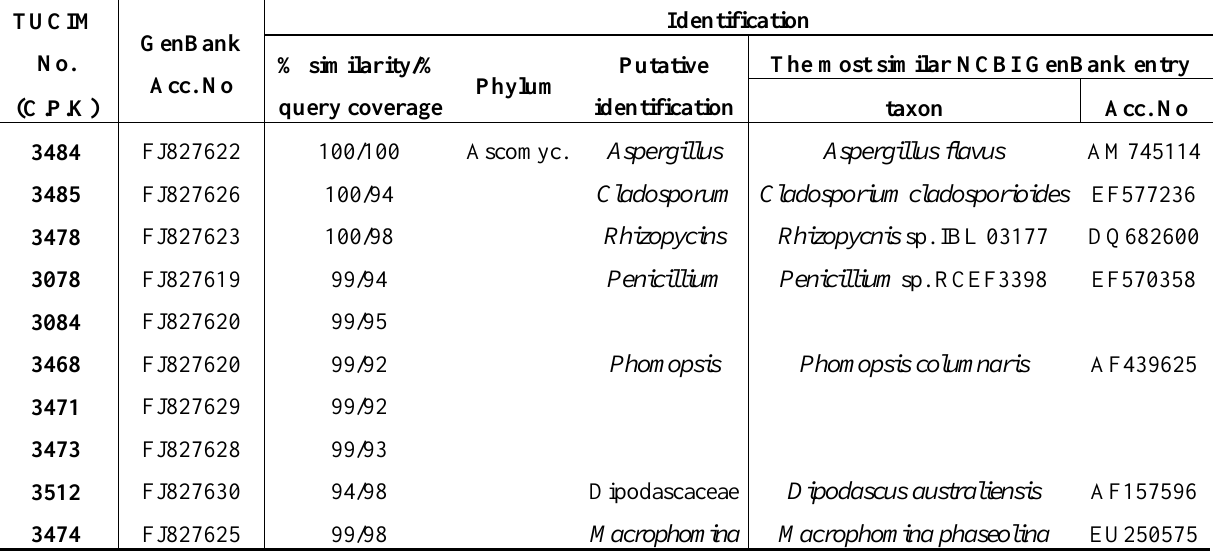
Table 1. List of endophytic fungi (without Trichoderma spp.) isolated from the roots of C. arabica and their identification based on tef1